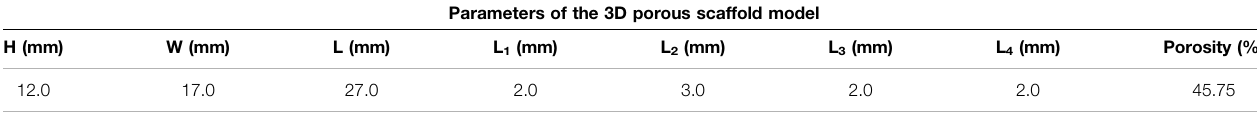
TABLE 1 | Parameters of the 3D porous scaffold